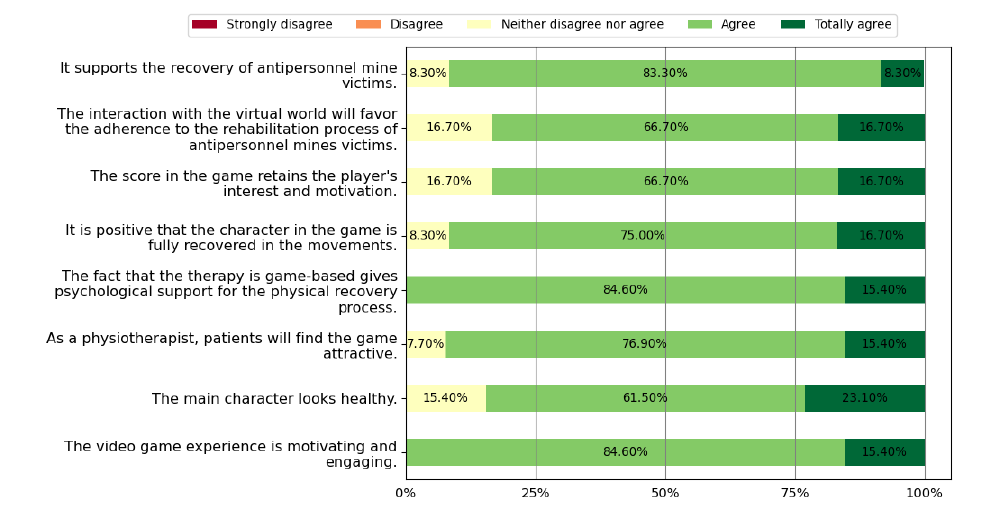
Figure 7. Perceptions related to physical rehabilitation.